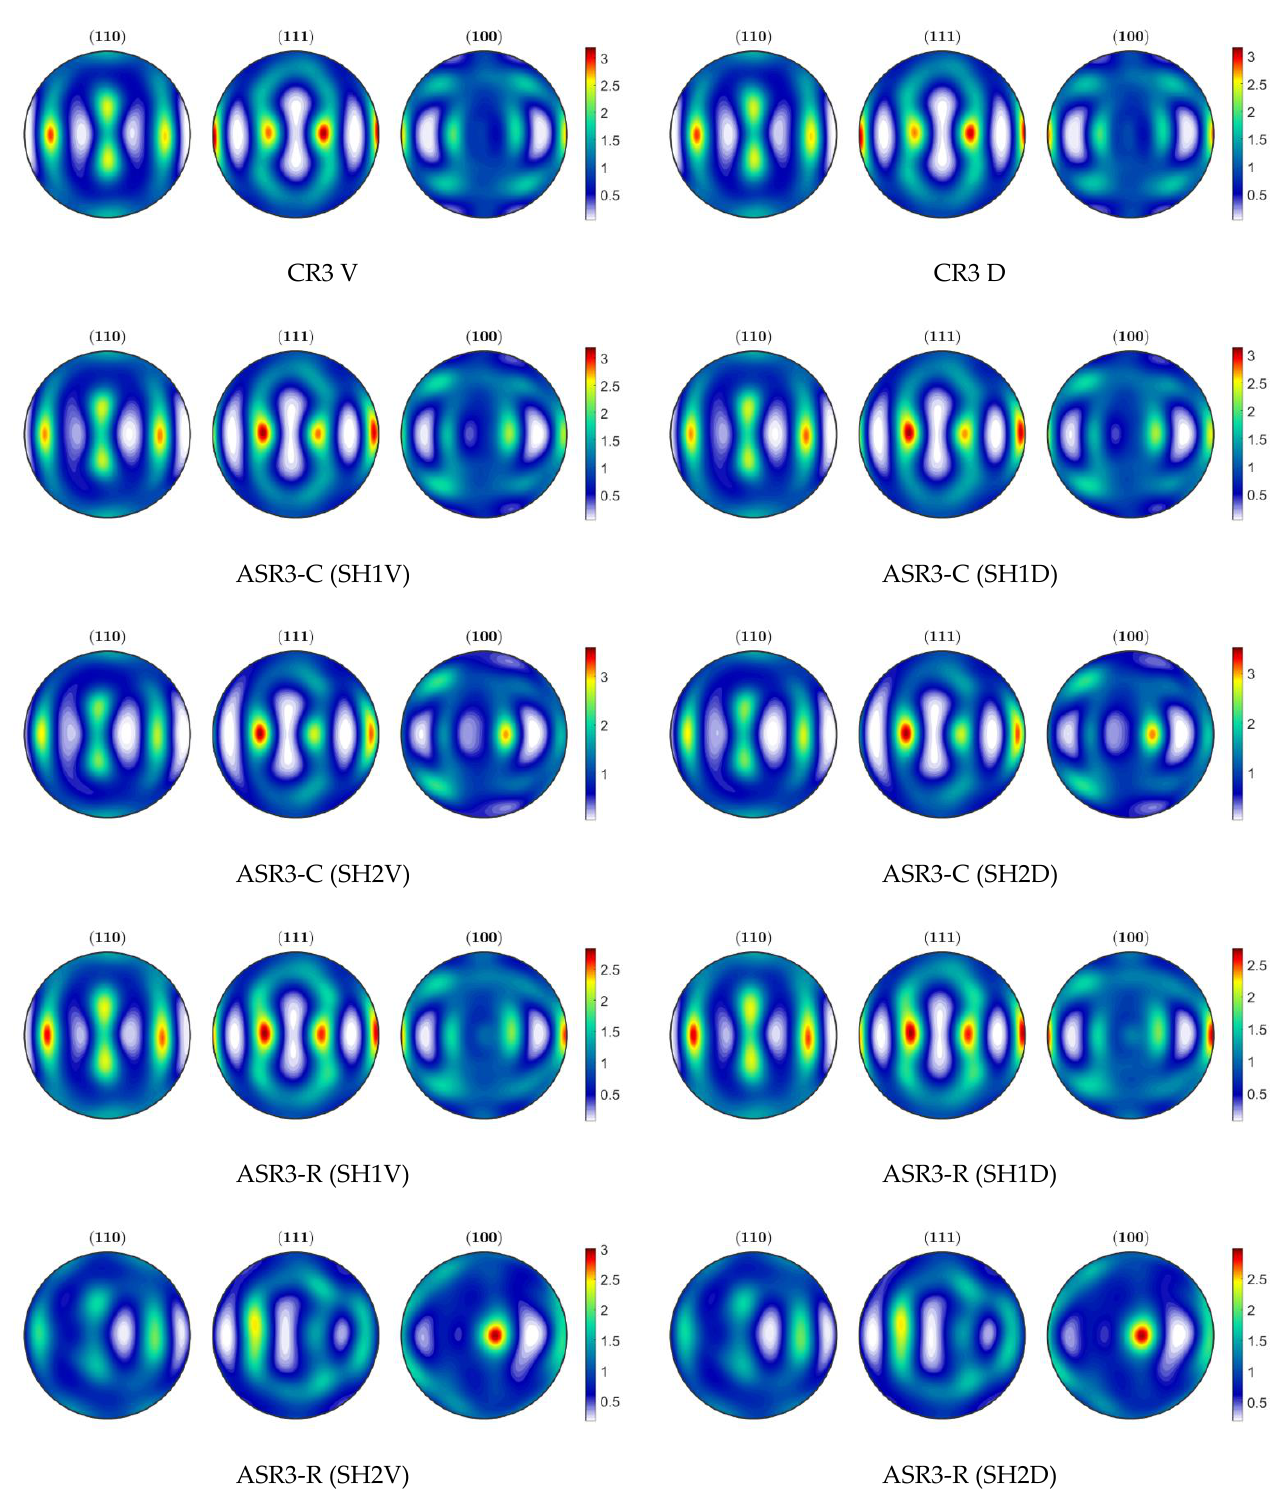
Figure A6. Pole figures for the third pass with a 20% thickness reduction per pass.